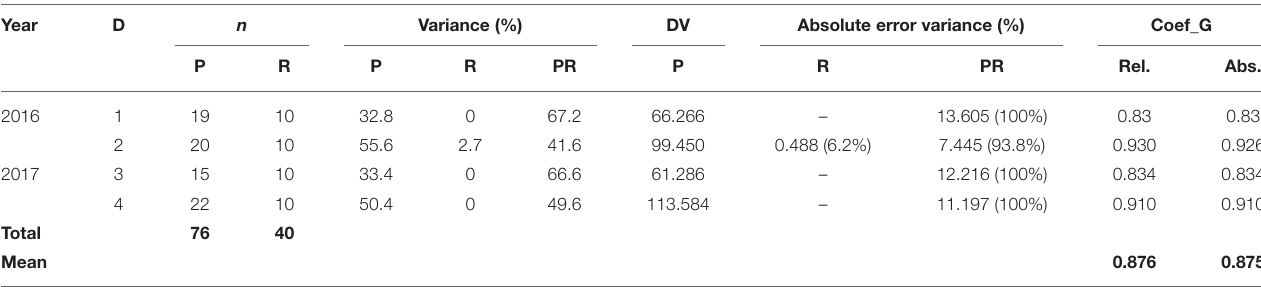
TABLE 1 | Generalizability